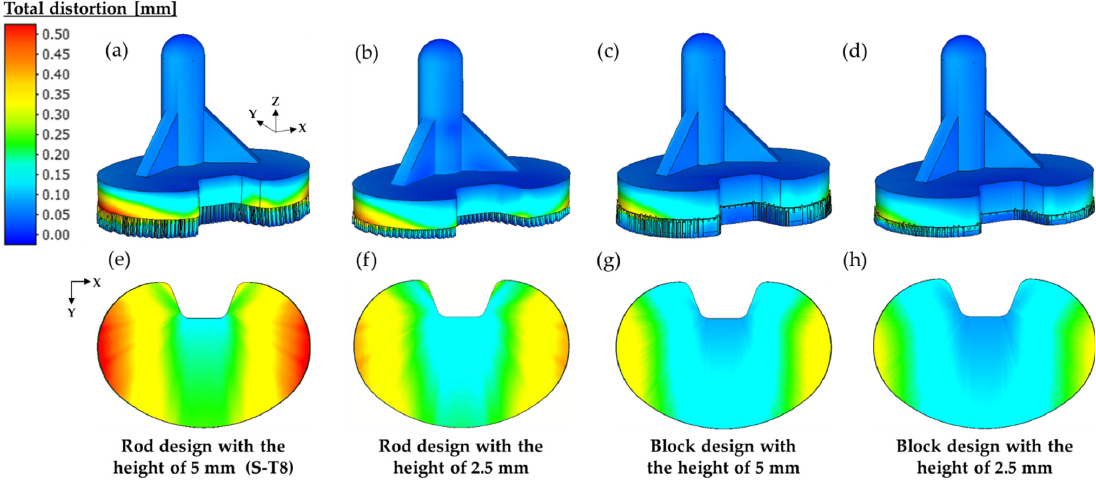
Figure 14. Total distortion distribution of as-built tibial component with different support structures and support heights. ( a , e ) Rod support-structure design with height of 5 mm (S-T8); ( b , f ) Rod support-structure design with height of 2.5 mm; ( c , g ) Block support-structure design with height of 5 mm; ( d , h ) Block support-structure design with height of 2.5 mm.